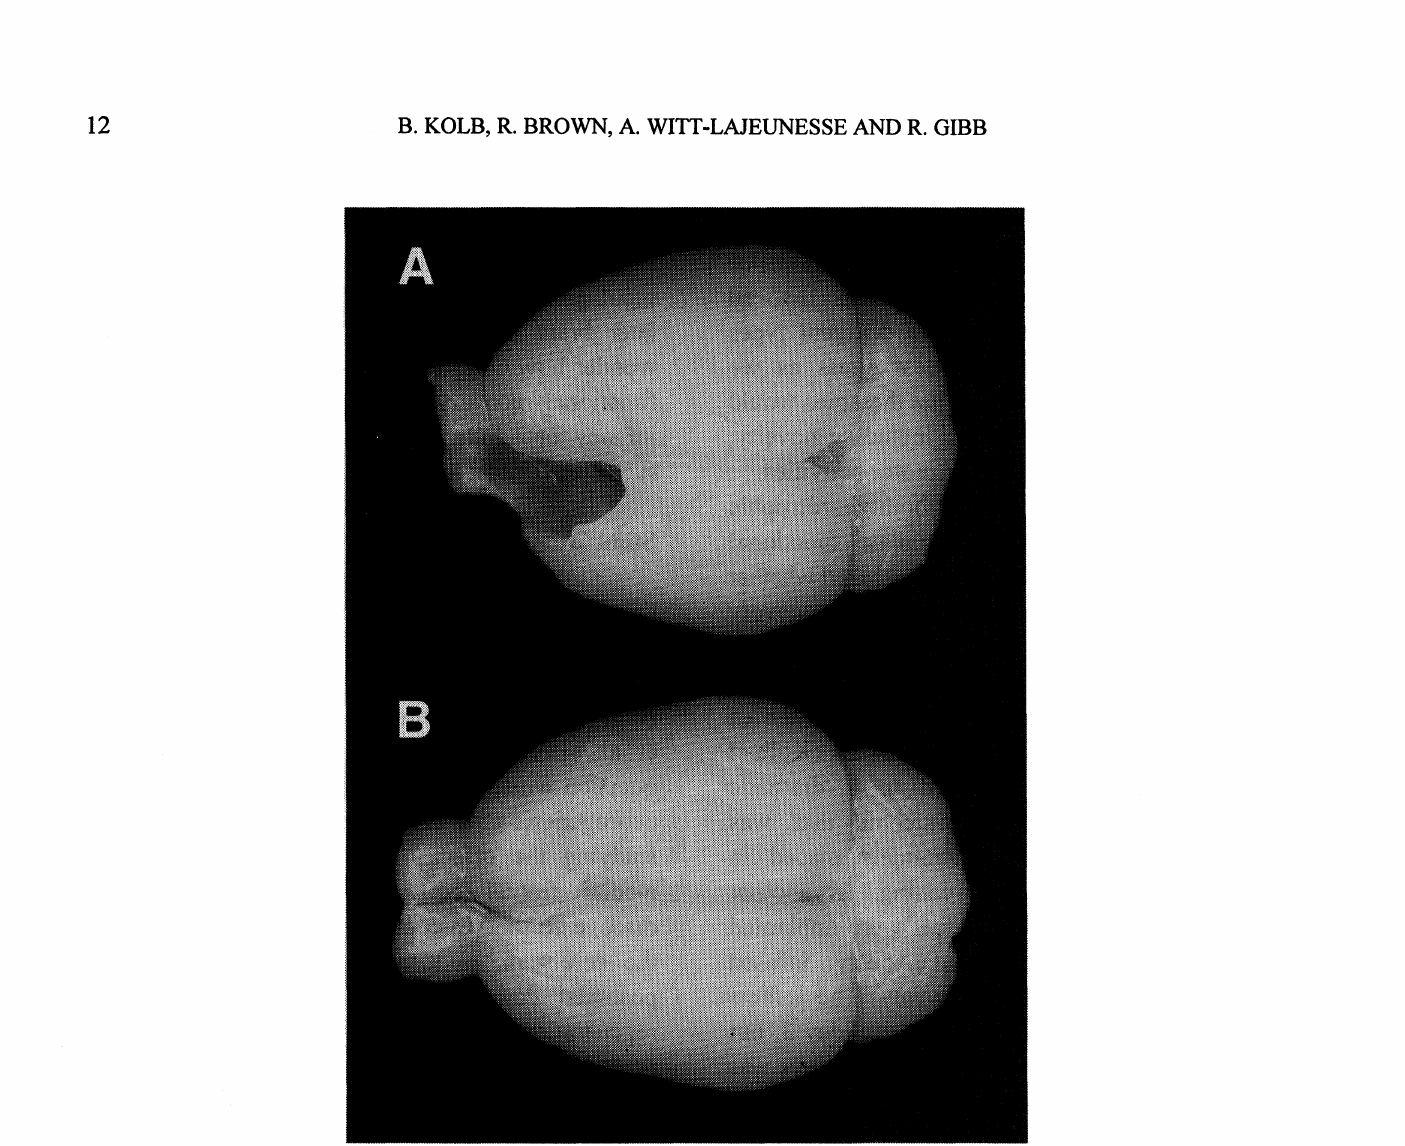
Fig. 5: Photographs of brains of rats that had either no treatment or a medial frontal lesion on posmatal day 10.